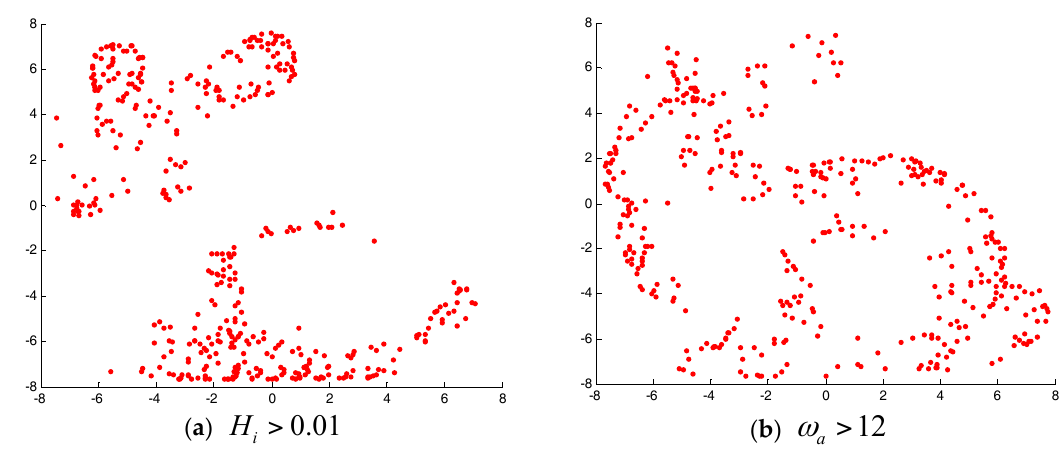
Figure 3. The detection results of three geometric features.